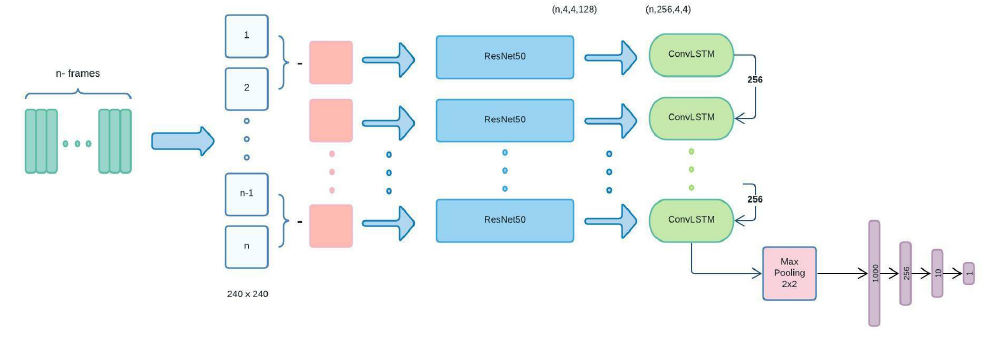
Figure 1. ResNet50ConvLSTM